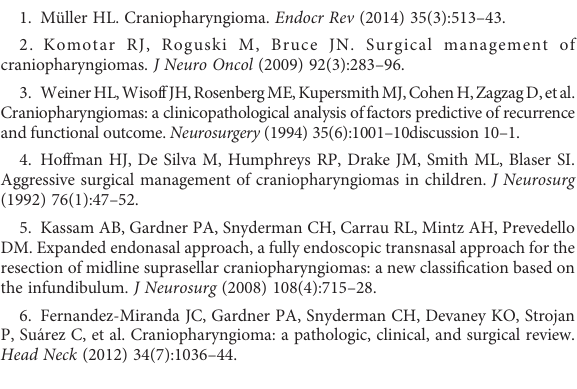
tomography; DI, diabetes insipidus; MRI, magnetic resonance imaging. SUPPLEMENTARY FIGURE 2 Immunostaining analysis revealed the expression of CK5/6 (A) , P63 (B)